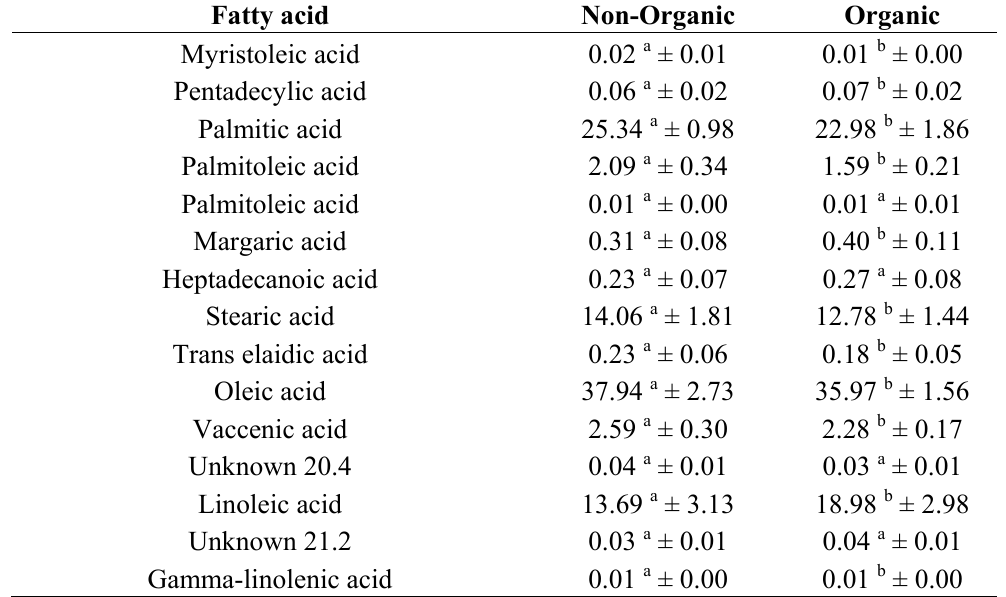
Table 4. Fatty acid composition of pork belly meat from the categories non-organic (conventional + free range) and organic expressed as percentage of normalized peak